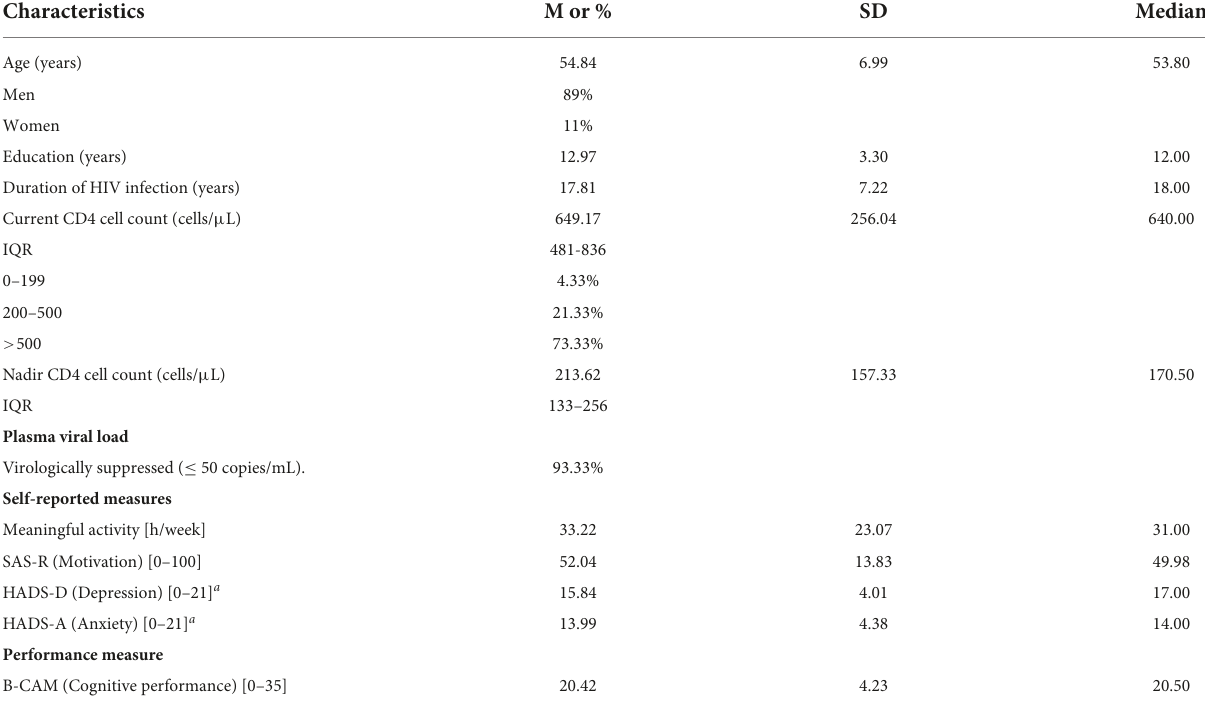
TABLE 1 Demographic and clinical characteristics of the sample ( N =